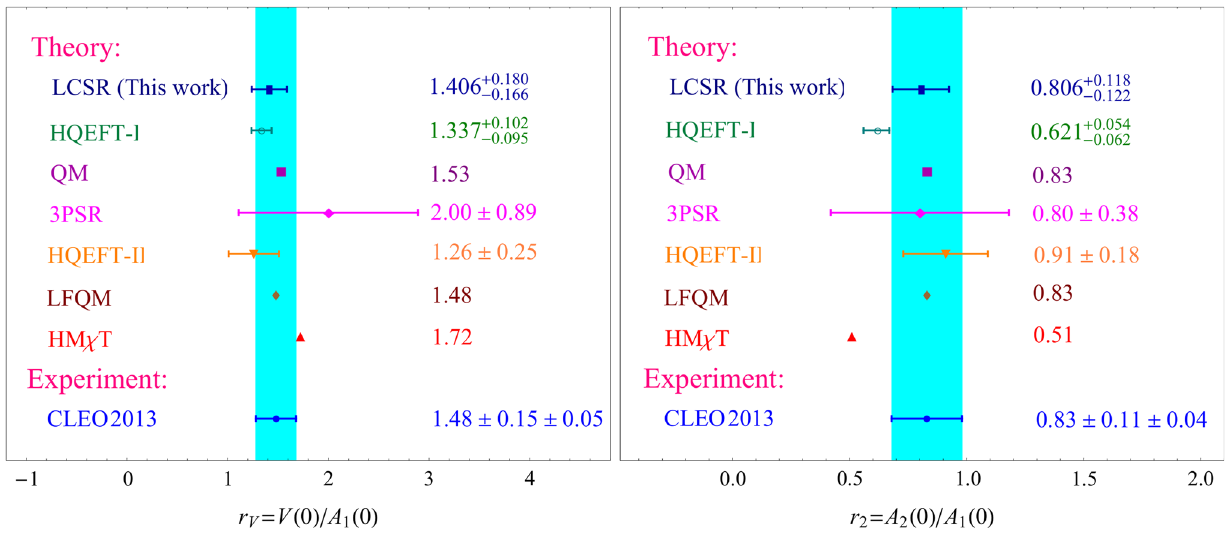
Fig. 6 Comparison of theoretical predictions for the ratios r 2 and r V within various approaches. The CLEO measurements are presented as a comparison